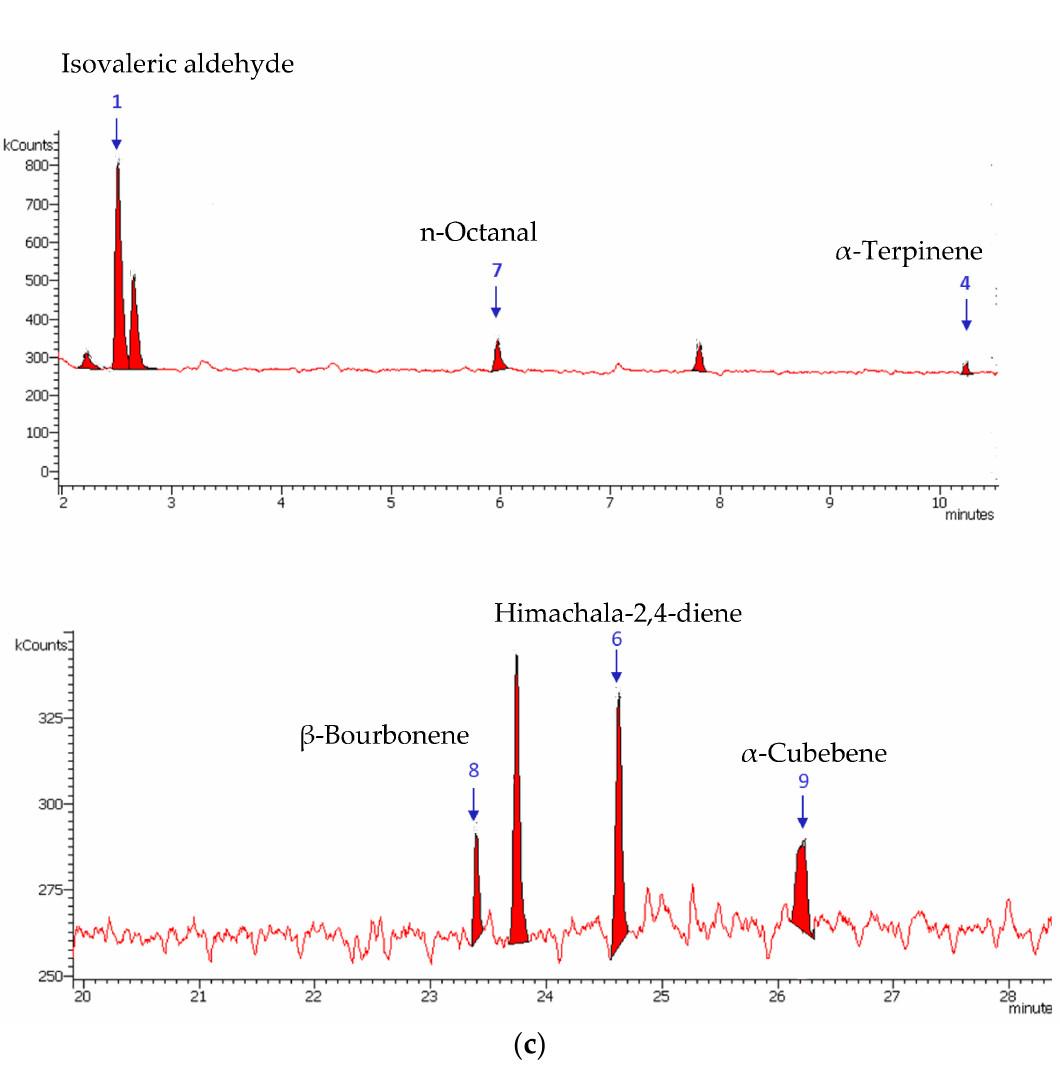
Table 2. Phytochemicals extracted from P. viscosa and identified by GC-MS.